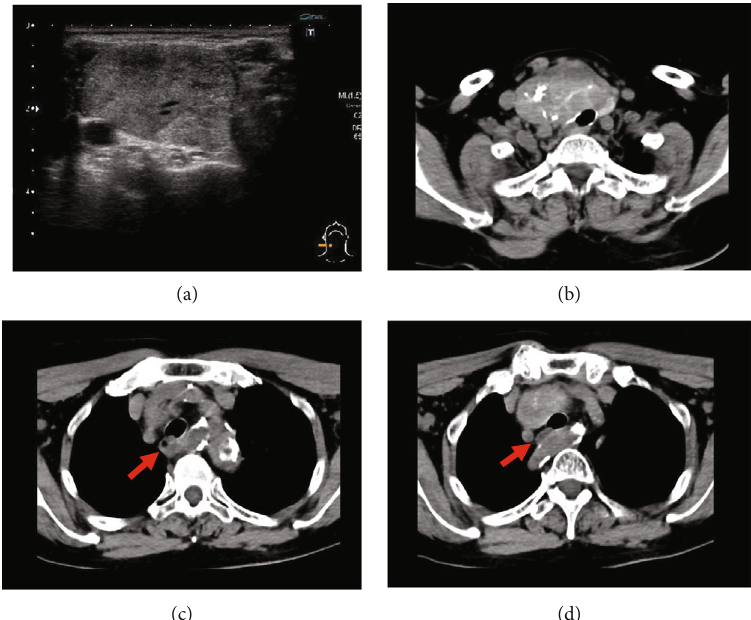
Figure 1: Preoperative imaging. (a) Ultrasonography showing a mass in the right thyroid lobe. (b) Computed tomography image showing the thyroid tumor with calci fi cation compressing the cervical trachea. (c, d) The right aberrant subclavian artery (arrow) running behind the esophagus ( ∗